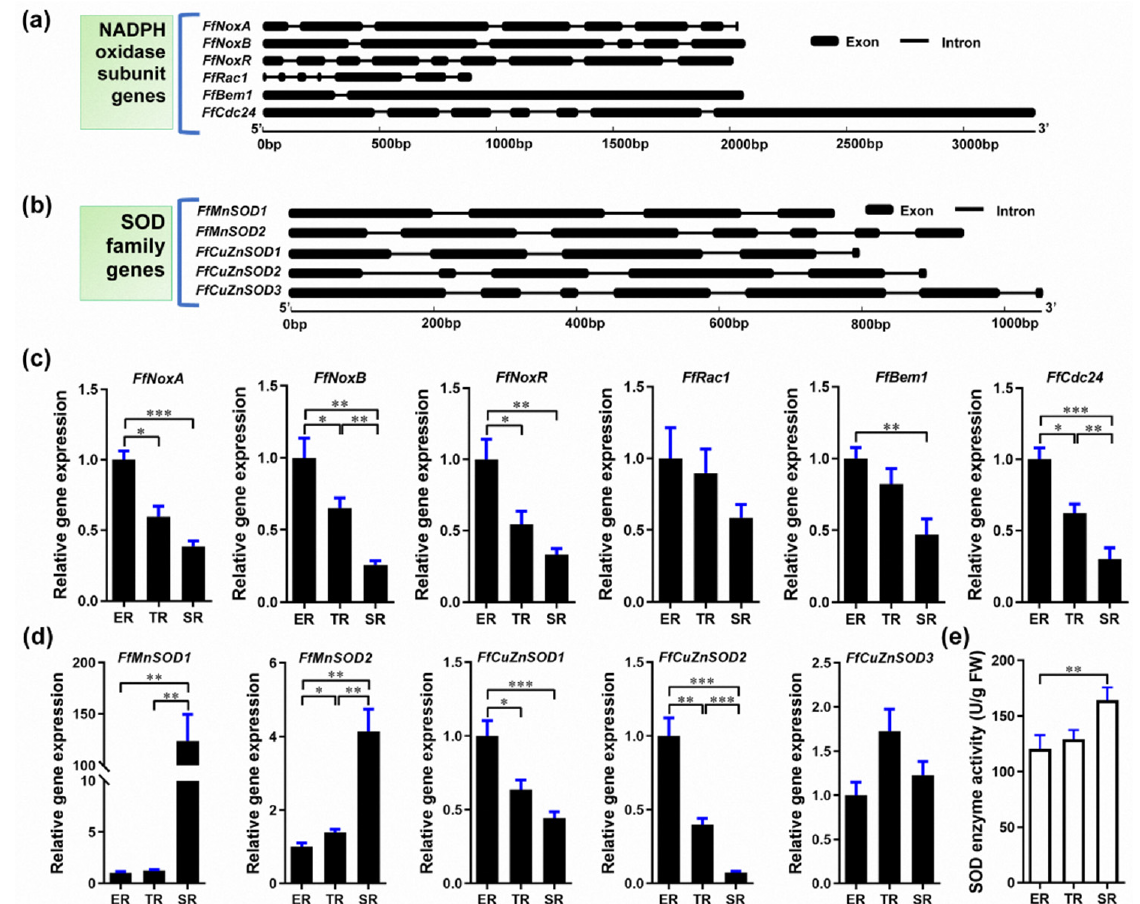
Figure 3. Identification of Flammulina NADPH and SOD homologs and their expression in the ER (elongation region), TR (transition region), and SR (stable region). ( a ) Gene structure of Flammulina NADPH oxidase subunit homologs. ( b ) Gene structure of Flammulina SOD family homologs. ( c ) Relative expression of genes encoding NADPH oxidase subunits in different stipe regions ( n = 6). ( d ) Relative expression of SOD family genes ( n = 6). ( e ) SOD enzyme activity ( n = 5) in different stipe regions. The significance levels were calculated by paired t -test and marked as follows: * p < 0.05, ** p < 0.01, *** p < 0.001.